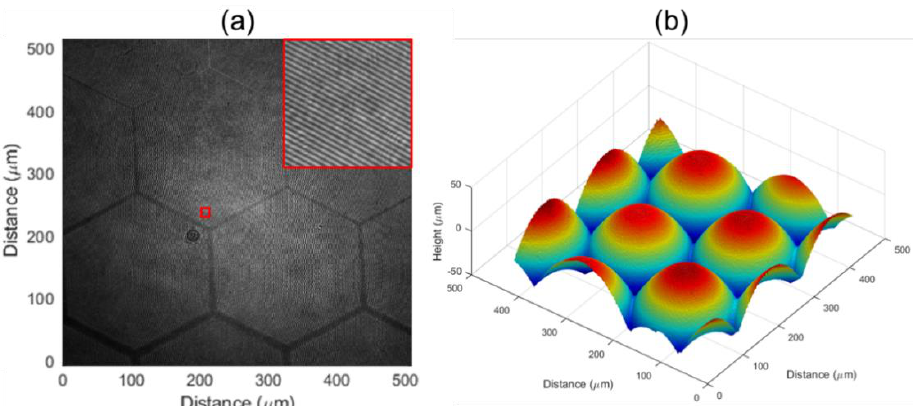
Figure 6. ( a ) Digital hologram recorded by transmission DHM and magnified central part. ( b ) Thickness information reproduced from ( a ).